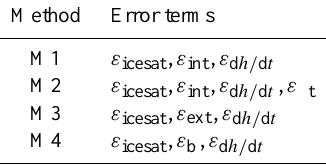
Table 2. ICESat point statistics of elevation change for the different Arctic regions. The values are in ma − 1 for the statistics and km 2 for the area, and N is the number of observations.